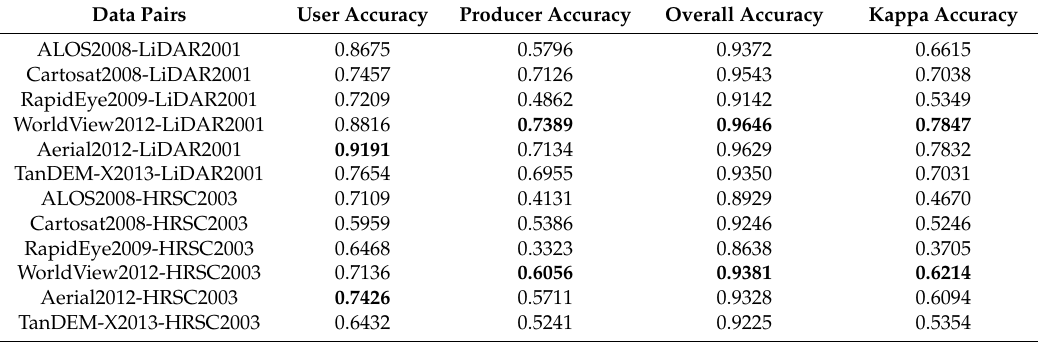
Figure 10. Forest change masks generated from: ( a ) ALOS2008–LiDAR2001; ( b ) Cartosat2008–LiDAR2001; ( c ) RapidEye2009–LiDAR2001; ( d ) WorldView2012–LiDAR2001; ( e ) Aerial2012–LiDAR2001; ( f ) TanDEM-X2013–LiDAR2001; ( g ) ALOS2008–HRSC2003; ( h ) Cartosat2008–HRSC2003; ( i ) RapidEye2009–HRSC2003; ( j ) WorldView2012–HRSC2003; ( k ) Aerial2012–HRSC2003; and ( l ) TanDEM-X2013–HRSC2003 overlaid with the reference mask. Green: true positives; red: false positives; blue: false negatives; grey: forest mask. Table 7. Comparison of the change masks generated from different combination of DSMs (highest values are marked in bold).